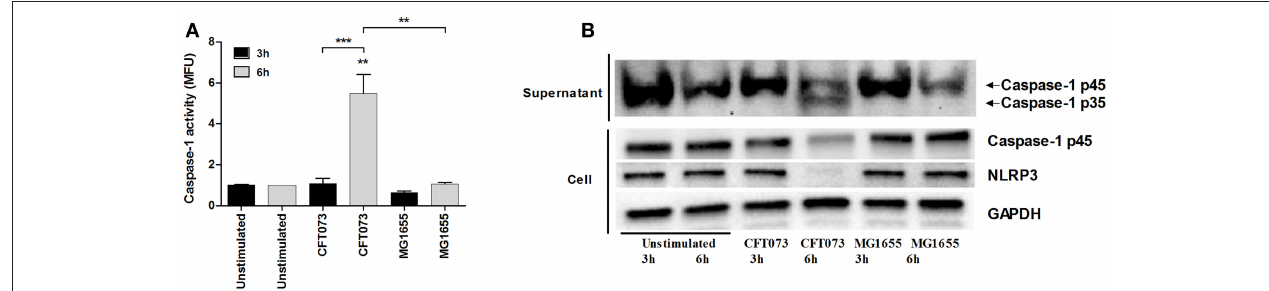
FIGURE 2 | Caspase-1 activity and protein expression of caspase-1 and NLRP3. The bladder epithelial cell line 5637 was infected with UPEC strain CFT073 and the non-pathogenic E. coli strain MG1655 at MOI 10 for 3 and 6h followed by analysis of caspase-1 activity (A) and caspase-1 and NLRP3 protein expression by Western blot analysis (B) . Caspase-1 activity is presented as fold increase of mean fluorescence units (MFU) compared to unstimulated control cells. GAPDH was used as a loading control for Western blots. Data are presented as mean ± SEM ( n = 3 independent experiments). Asterisks denote statistical significance compared to respective unstimulated control (** p < 0.01, *** p <